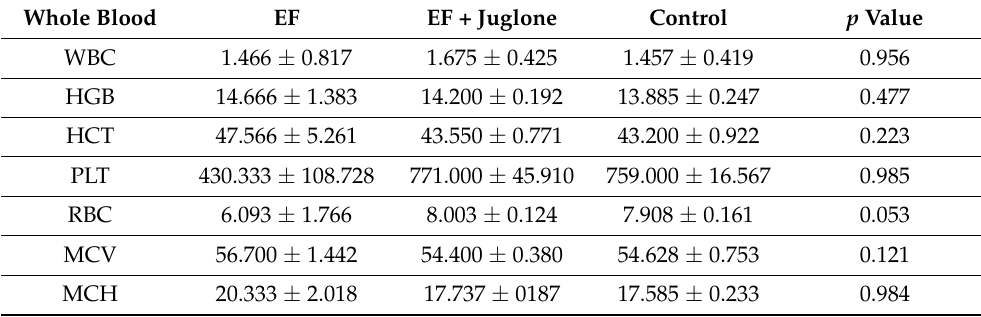
Table 2. Statistical evaluation of whole blood values of the groups by Kruskul–Wallis method ( p >